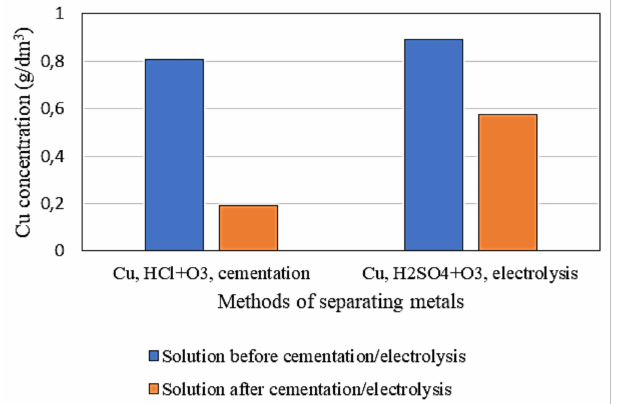
Figure 6. Comparison of copper content in the solution after leaching, collected before and after cementation and electrolysis.